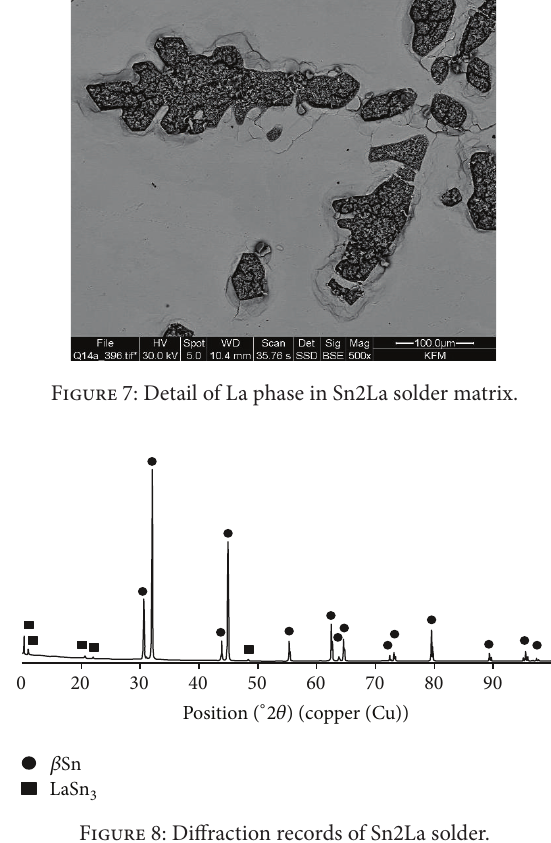
Figure 8: Diffraction records of Sn2La solder.